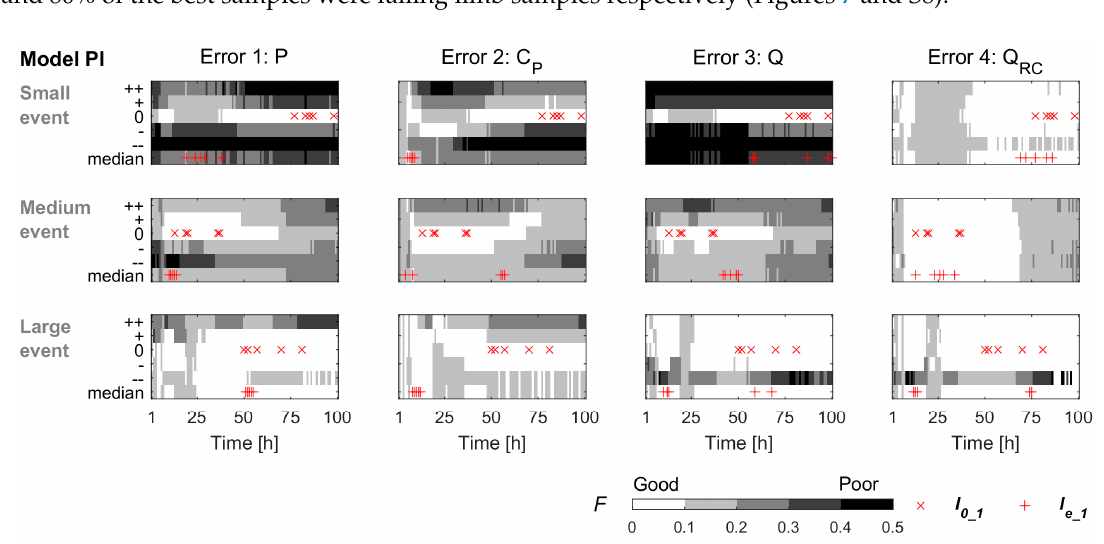
Figure 7. Validation performance ( F ) of the models calibrated with one sample (grey scale), as well as the timing of the five most informative samples when there are no data errors (0; red crosses) and when there are data errors (median for the five error magnitudes (red plusses)) for the different error types, for the small ( top row ), medium ( middle row ) and large ( bottom row ) event for parameterization PI.